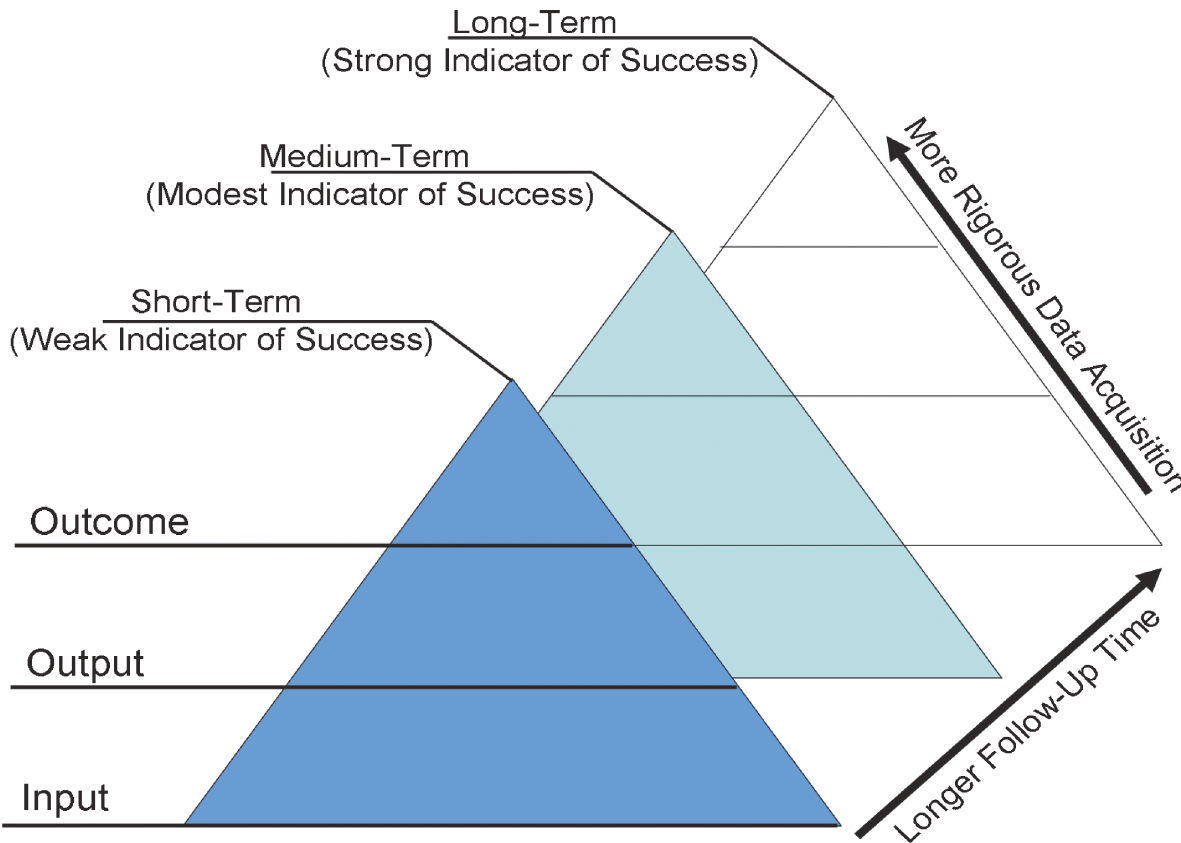
Fig 1. Logic model of program monitoring and evaluation. Inputs, outputs and outcomes of programmes are evaluated with increasingly rigorous data collection. Inputs refer to equipment, finances and time invested in order to achieve outputs, such as better trained surgeons or increased surgical output. The outputs result in processes, such as ongoing staff training. The outputs, if successful lead to outcomes that have a measureable impact, such as lower morbidity and mortality of surgical interventions in LMICs. Success of the program is evaluated over the short, medium and long term whereby short term indicators of success, such as the number of operations performed during a single visit, offer a weak indication of success; Long term indicators of success, such as a recorded decrease in morbidity associated with a particular surgical condition, offer a strong indicator of program success.